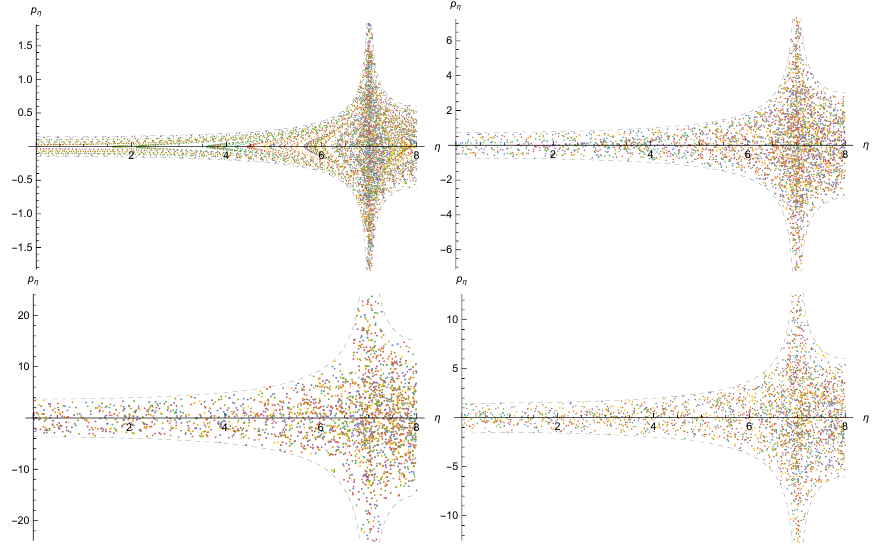
Figure 5 . (cid:17) (cid:0) P (cid:17) plane projections of the Poincare section at (cid:31) = 0 for the one-kink spacetime. Clockwise from top left we vary the parameter E = f 0 : 1 ; 0 : 5 ; 1 ; 2 : 5 g . The plots (cid:12)ll an area bounded by maximal value of P (cid:17) compatible with the constraint that H = 0 indicated with a grey dashed line. The 100 di(cid:11)erent seed initial conditions that are numerically evolved to generate these sections are indicated by colour. For small values of E we have a perturbation around an integrable Hamiltonian (for E = 0 the Hamiltonian is trivial and vanishing) and one sees vestiges of KAM tori which as E is increased dissolve away.